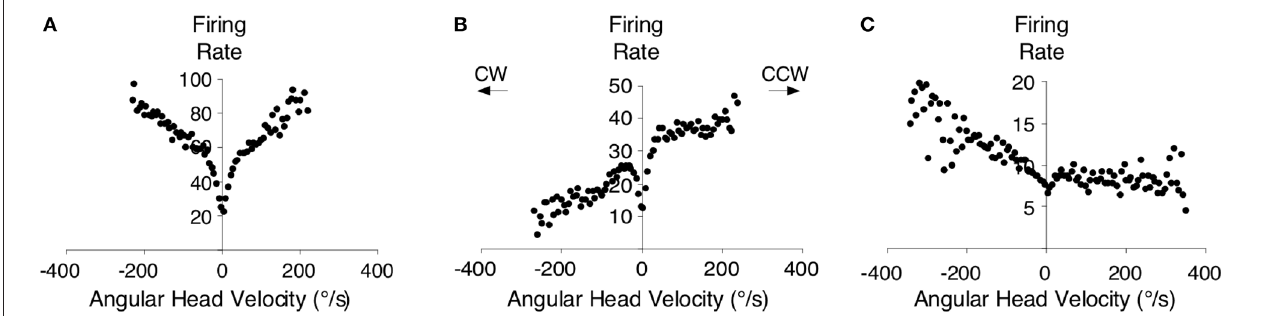
FIGURE 7 | An example of a symmetric angular head velocity cell is shown in (A) and representative examples of asymmetric angular head velocity cells are shown in (B,C). Clockwise (CW) and counter-clockwise (CCW) directions are as indicated. Plots in (A–C) are from Bassett and Taube